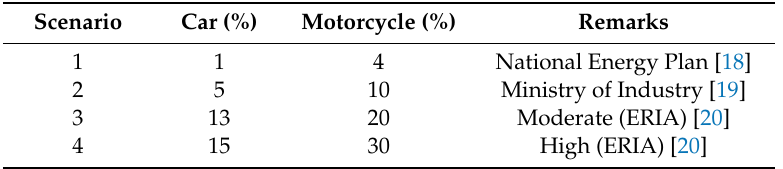
Table 4. EV penetration